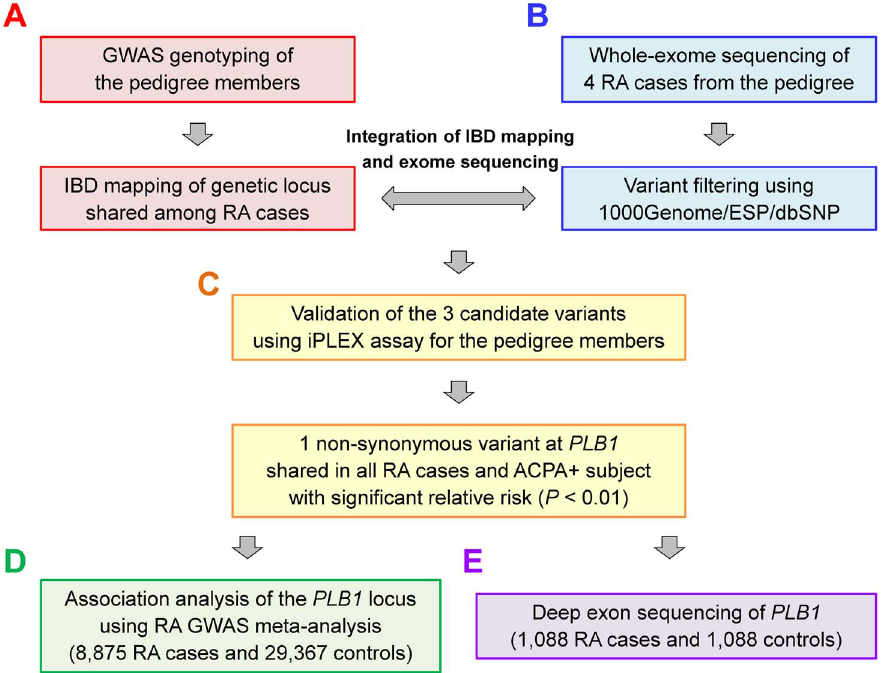
Figure 1. Description of the study design. Our study consists of analysis on three sources of data: (1) rare risk variant detection in the consanguineous pedigree with Mendelian form of RA (A–C), (2) regional association analysis using RA GWAS meta-analysis of European populations (D), and (3) target deep exon sequencing of the European RA case-control cohort (E). (A) We conducted IBD mapping of the pedigree using genome- wide SNP genotype data. (B) Whole-exome sequencing was performed for the 4 affected RA cases of the pedigree. (C) By integrating the results of IBD mapping and whole-exome sequencing, and subsequently conducting the validation assay, we identified a non-synonymous mutation of PLB1 associated with RA segregation. (D) We evaluated the regional association of the PLB1 locus using RA GWAS meta-analysis including 8,875 RA cases and 29,367 controls. (E) Deep exon sequencing of PLB1 and gene-based rare variant test was conducted for 1,088 RA cases and 1,088 controls.